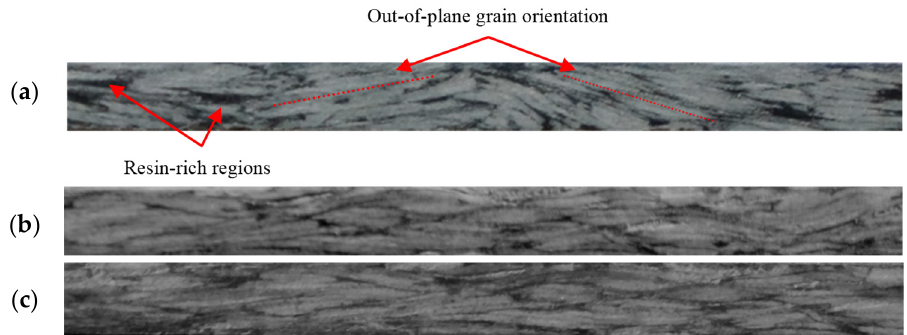
Figure 8. Cross section for respectively ( a ) RA250510001003, ( b ) RA250510000753 and ( c ) RA250510000503 specimens.